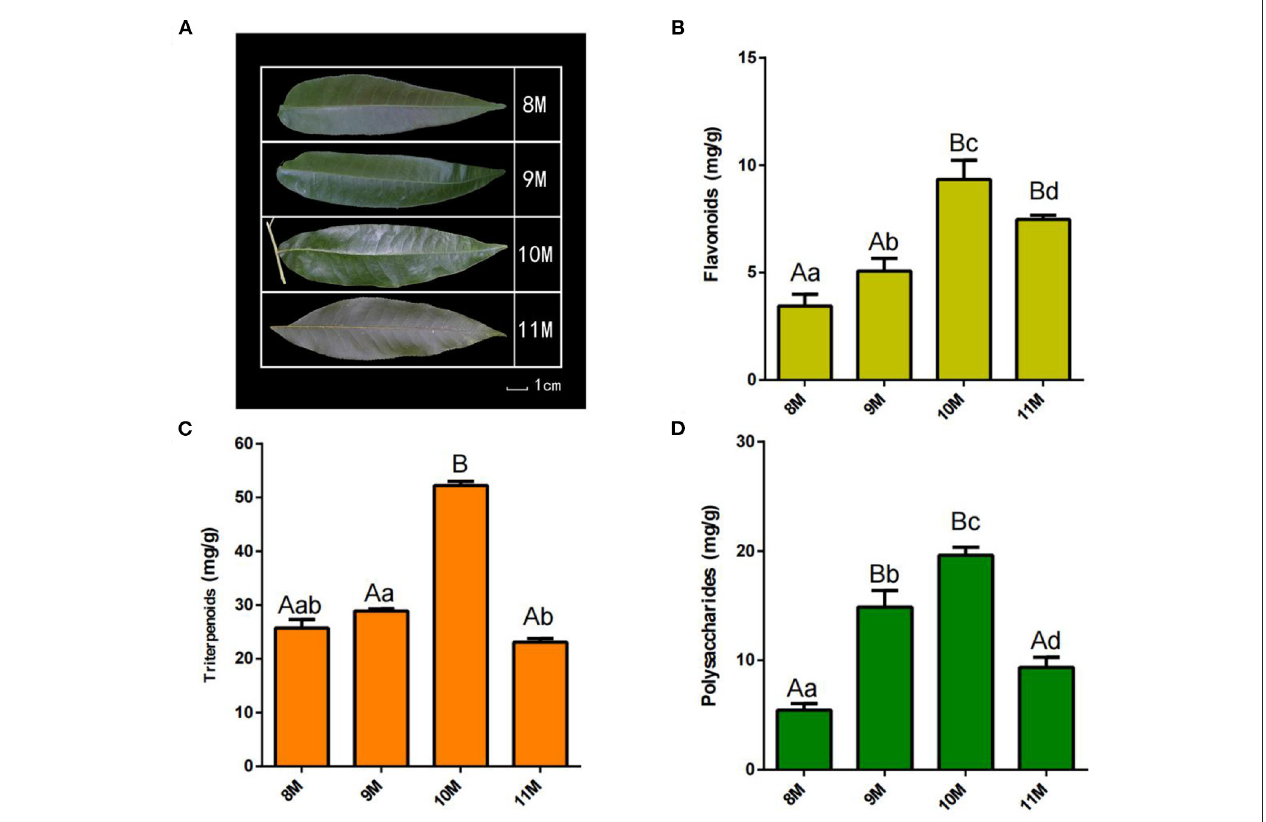
FIGURE 1 | Phenotype and physiological-biochemical indices of C. paliurus leaves. (A) Morphological observation of C. paliurus leaves from different harvest times. (B) Total triterpenoids content. (C) Total polysaccharides content. (D) Total flavonoids content. Bar = 1cm. Error bars indicate standard deviation. Capital letters and small letters indicate that significance is at 0.01 or 0.05